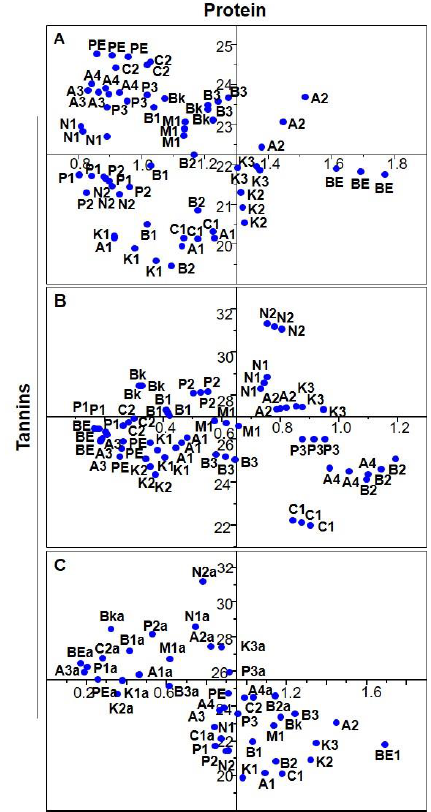
Figure 5. Plot of tannins vs. protein content of 10 common bean cultivars, grouped according to their morphological characteristics. Cultivars: Arikara yellow (A1, A2, A3, A4), butter bean (B1, B2, B3), cranberry (C1, C2), red kidney (K1, K2, K3), navy (N1, N2), pinto (P1, P2, P3), black (Bk), brown eyed (BE), pink eyed (PE), and tarrestre (M). ( A ) Triplicates of each sample from 2013, ( B ) triplicates of each sample from 2014, ( C ) average of each sample in both years, the samples being divided according to their harvest years.